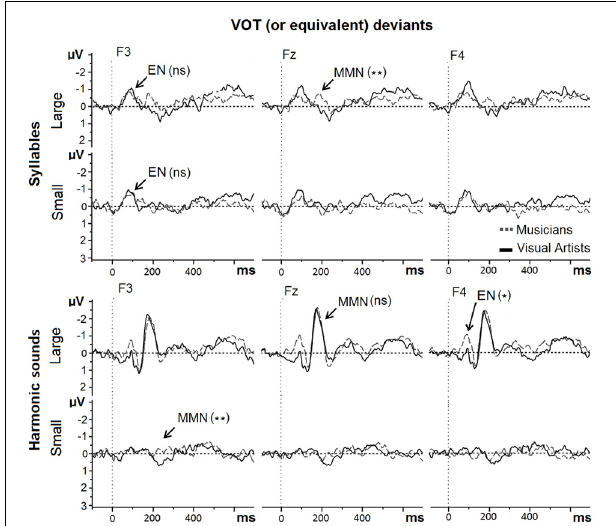
FIGURE 5 | MMNs to large and small VOT (or equivalent) deviants in Mandarin syllables and in harmonic sounds recorded at Frontal sites (F3, Fz, and F4) are overlapped for musicians (gray dashed line) and visual artists (black solid